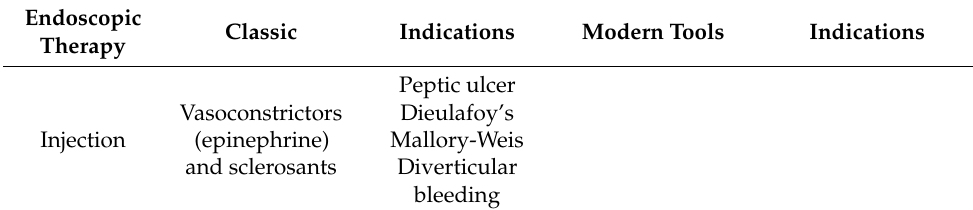
Table 6. Summary of endoscopic therapies and their uses in upper and lower